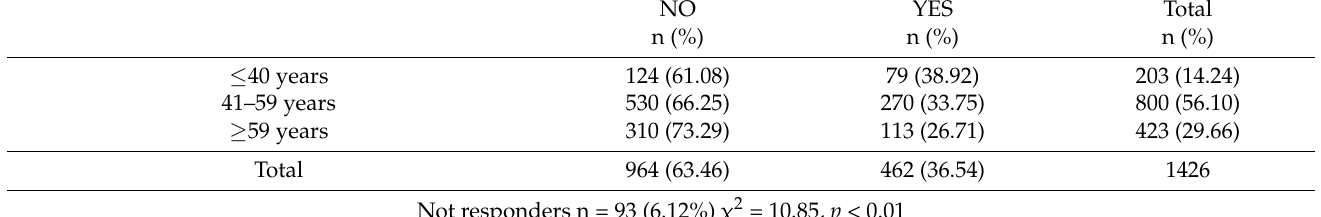
Table 2. Survey of the participants on whether they experienced a collapse and/or quarantine measures due to a positive test/infection/disease of dental personnel. The participants were stratified by age, employment relationships and which practice structure they work